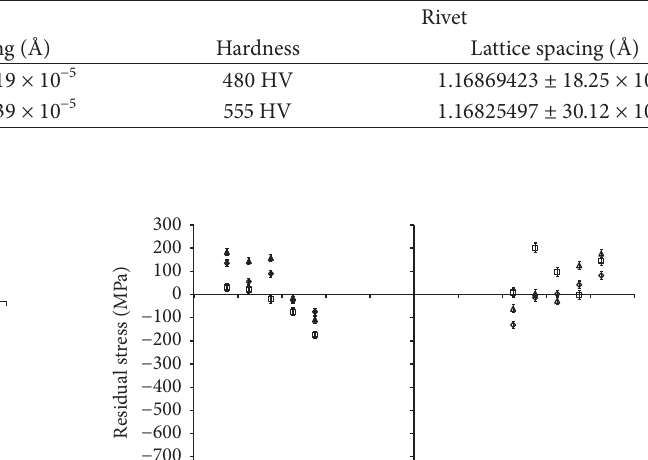
Table 4: Reference lattice spacing 𝑑 r of the sheets and rivets used to produce the selected joints.